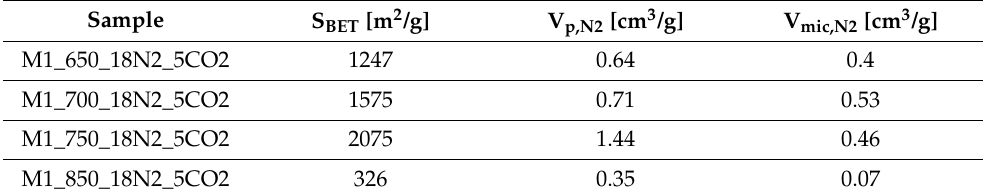
Table 1. Textural parameters for activated carbons, derived from N 2 adsorption isotherms at − 196 ◦